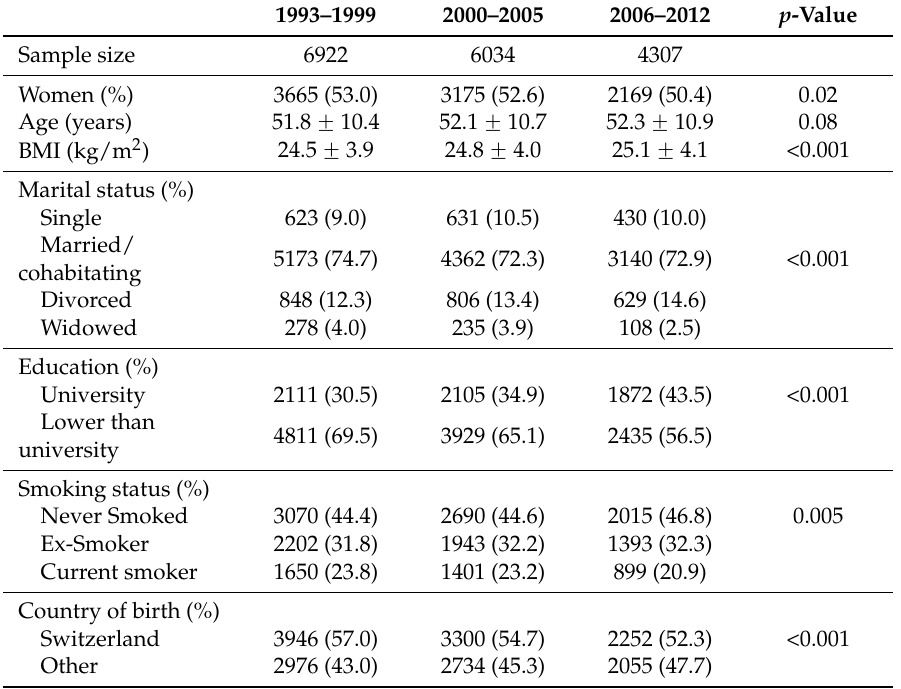
Table 1. Characteristics of the participants of the “Bus Santé” study, Geneva, Switzerland, according to study